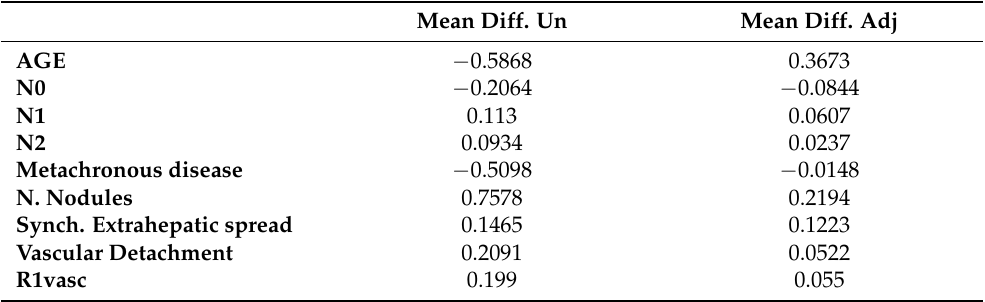
Table A1. Mean difference among variables selected for IPW before and after the weighting.